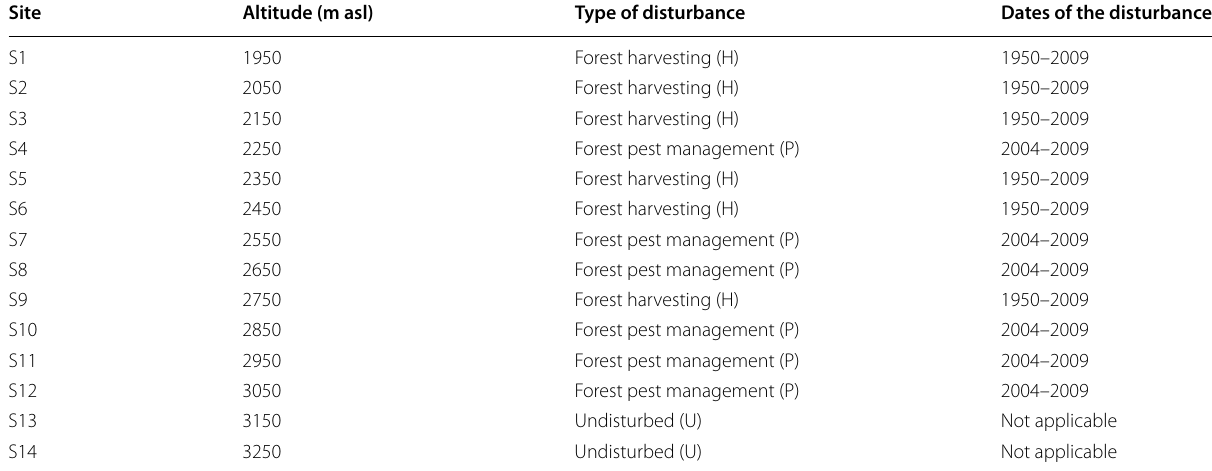
Table 1 Type and dates of the disturbance for each plot